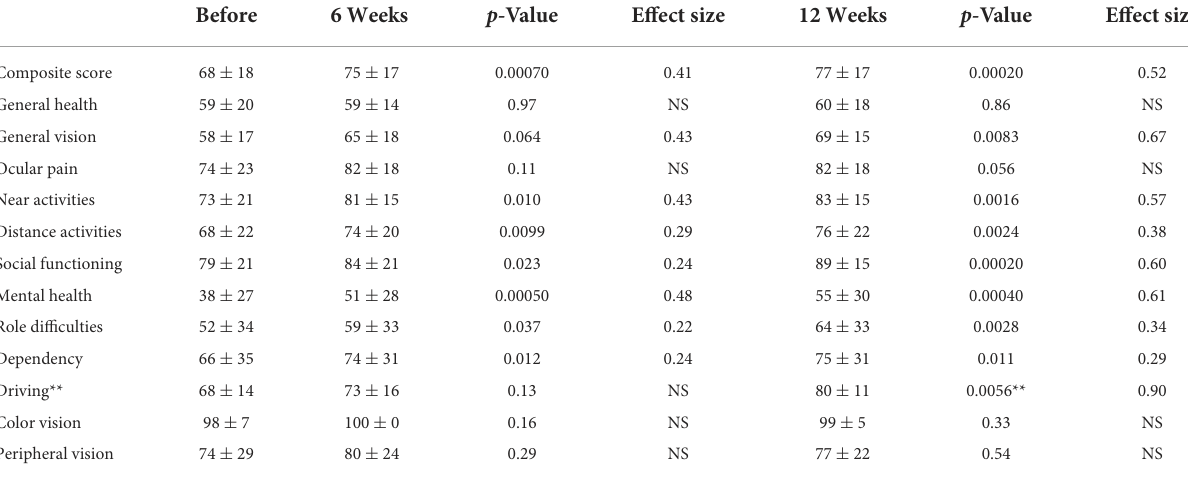
TABLE 2 Participants mean NEI-VFQ-25 composite and subscale scores before and after NORT treatment with associated effect size. Before 6 Weeks p -Value Effect